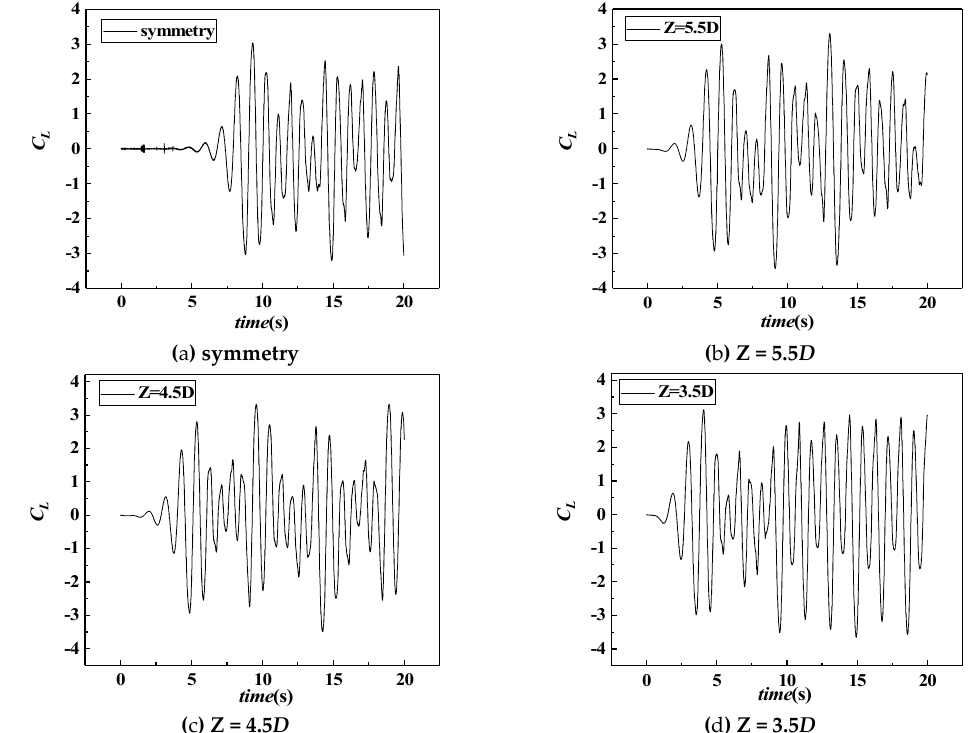
Figure 6. Time history of C L of the passive turbulence control (PTC) cylinder flow-induced vibration for different Zs (Re = 3.5 × 10 4 ). Energies 2020 , 13 , x FOR PEER REVIEW